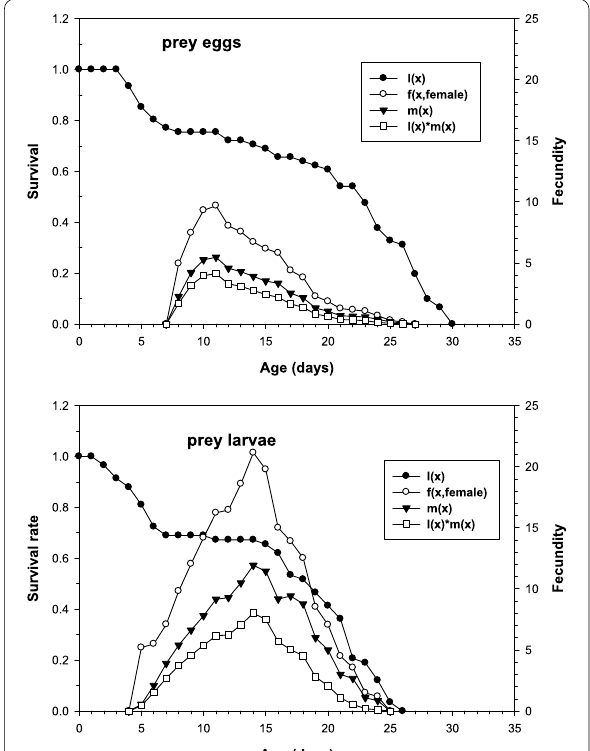
Fig. 2 Age-specific survival rate ( l x ), age-stage fecundity of female ( f x5 ) (eggs/female), age-specific fecundity ( m x ) and age- specific maternity ( l x m x ) of Blattisocius mali on eggs and larvae of Tyrophagus putrescentiae Fig. 3 Age-stage specific life expectancy ( e xj ) of Blattisocius mali on